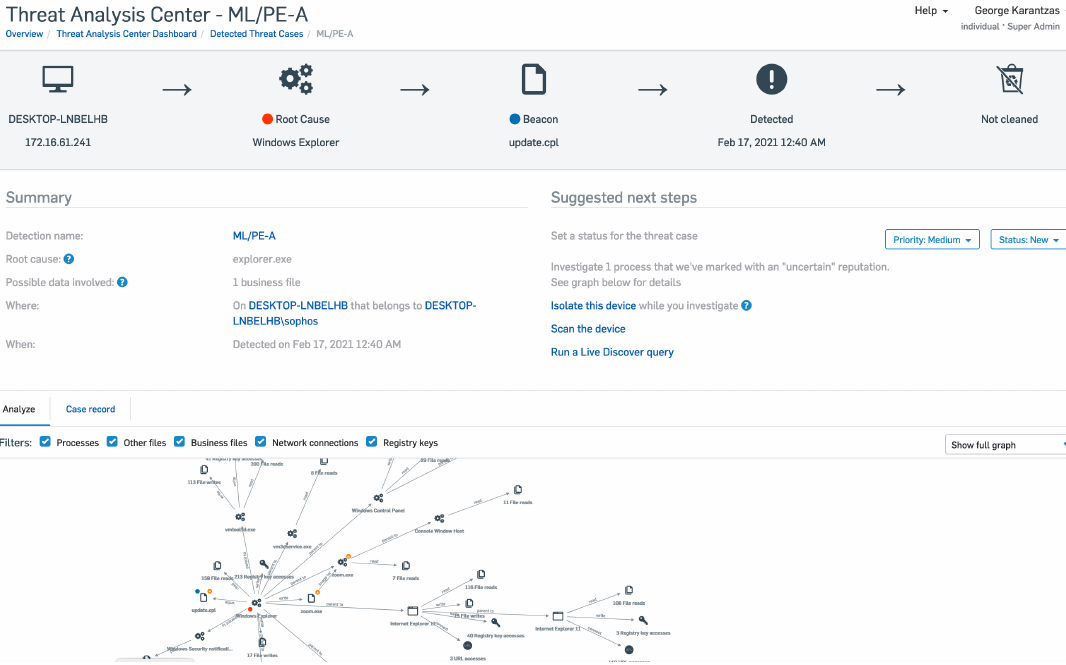
Figure 20. CPL was blocked by Sophos. Details and